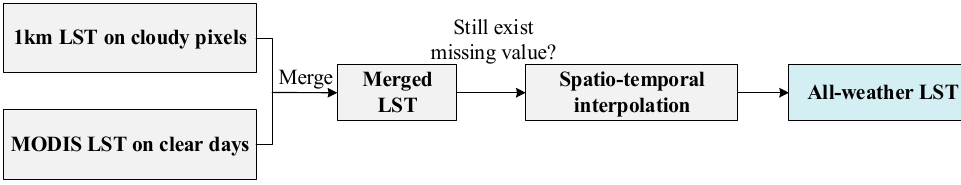
Figure 6. Procedure for merging estimated LST on cloudy pixels with MODIS LST. Inverse distance weighting (IDW), regular kriging (Kriging) and regular spline